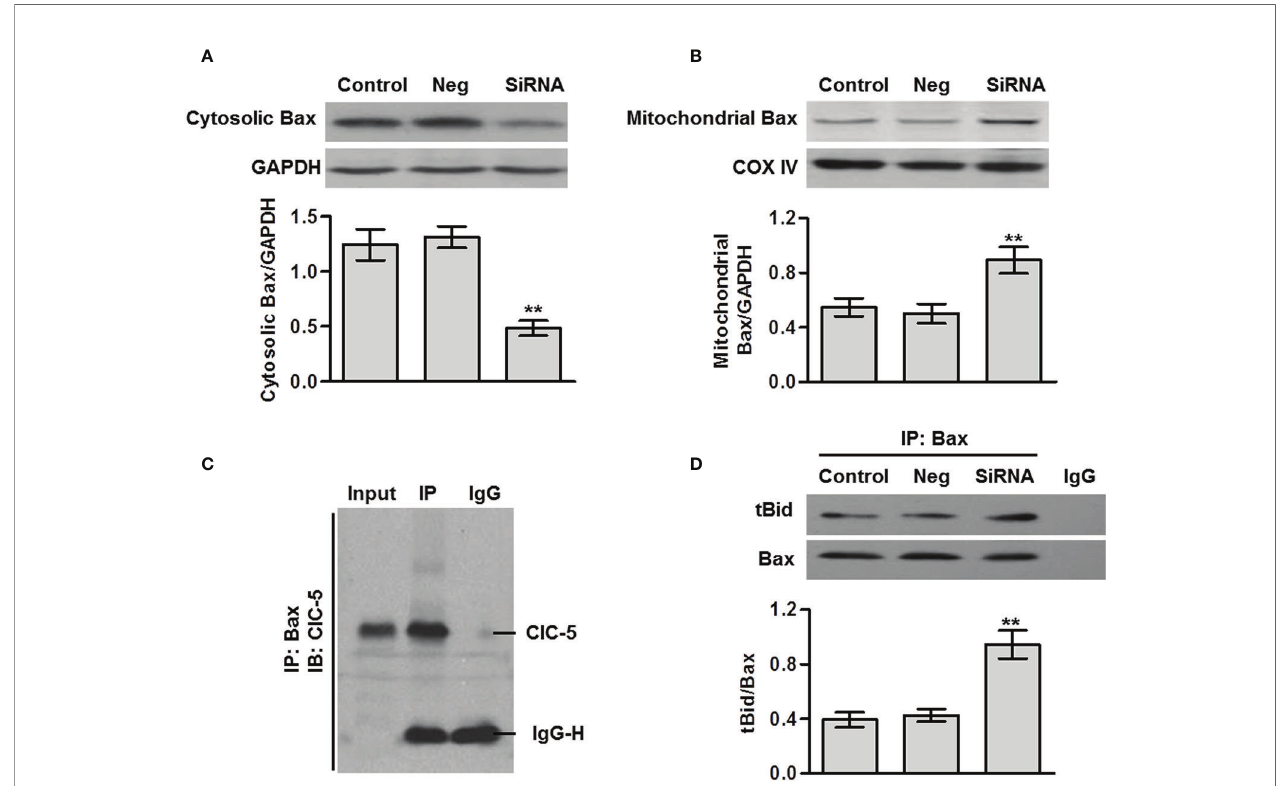
FIGURE 5 | ClC-5 interacts Bax and induces its translocation. (A and B) U-2OS osteosarcoma cells were transfected with ClC-5 siRNA or negative siRNA (Neg) for 48 h. The Bax expression in cytosol (A) and mitochondria (B) fractions was determined by western blotting. **P < 0.01 vs. control, n = 6. (C) Cell lysates were immunoprecipitated (IP) with Bax antibody and the immunoprecipitated proteins were blotted with ClC-5 antibody. (D) Cell lysates from each group were immunoprecipitated with Bax antibody and blotted with tBid antibody. **P < 0.01 vs. control, n =